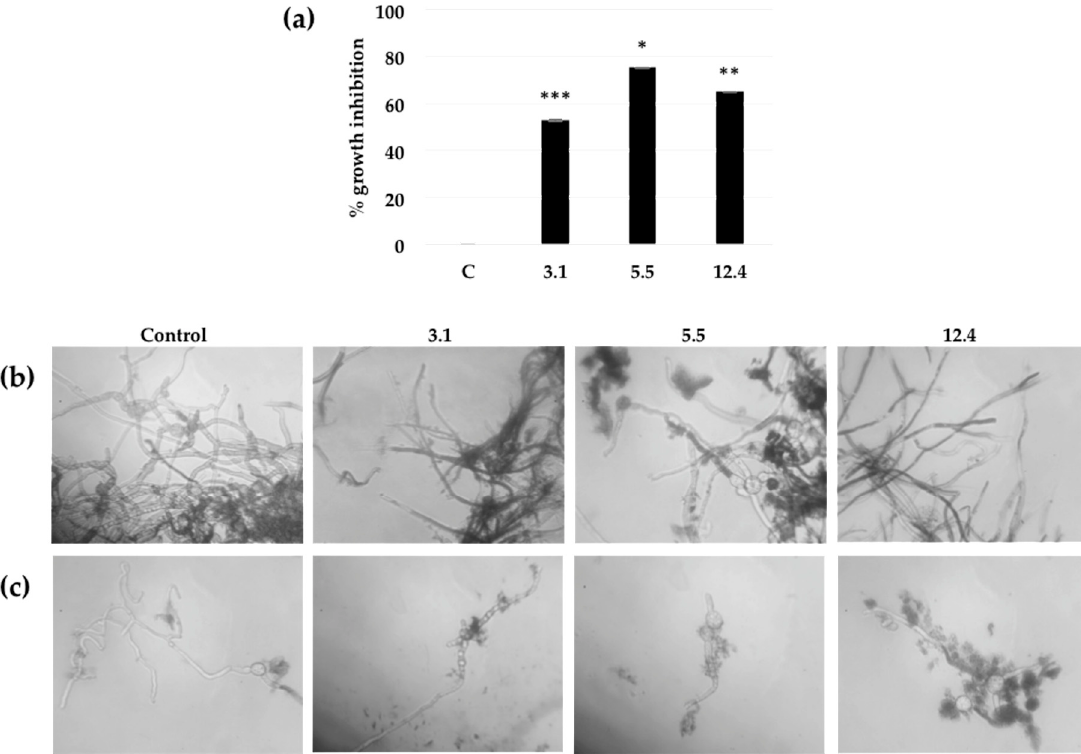
Figure 5. The e ff ect of chitinase SmChiC protein in leaf extracts from homozygous transgenic tobacco plants over B. cinerea growth and spore germination. ( a ) After 48 h of incubation, percentage of fungal growth inhibition is defined as 100 × the ratio of the corrected A 595 of the control plant minus the corrected A 595 of the sample over the corrected A 595 of the control plant. Each bar value represents the mean ± SD of triplicate experiments (Student’s t test; ***, p = 0.0002; *, 0.0165; **, 0.0053 for each line respectively versus control). ( b ) Microscopic analyses of the appearance of the B. cinerea hyphae after incubation for 48 h in presence of di ff erent plant crude extract. Magnification target (40 × ). ( c ) Microscopic analyses of the appearance of B. cinerea single spore hyphae after incubation for 48 h in presence of di ff erent plant crude extract. Magnification 40 × .